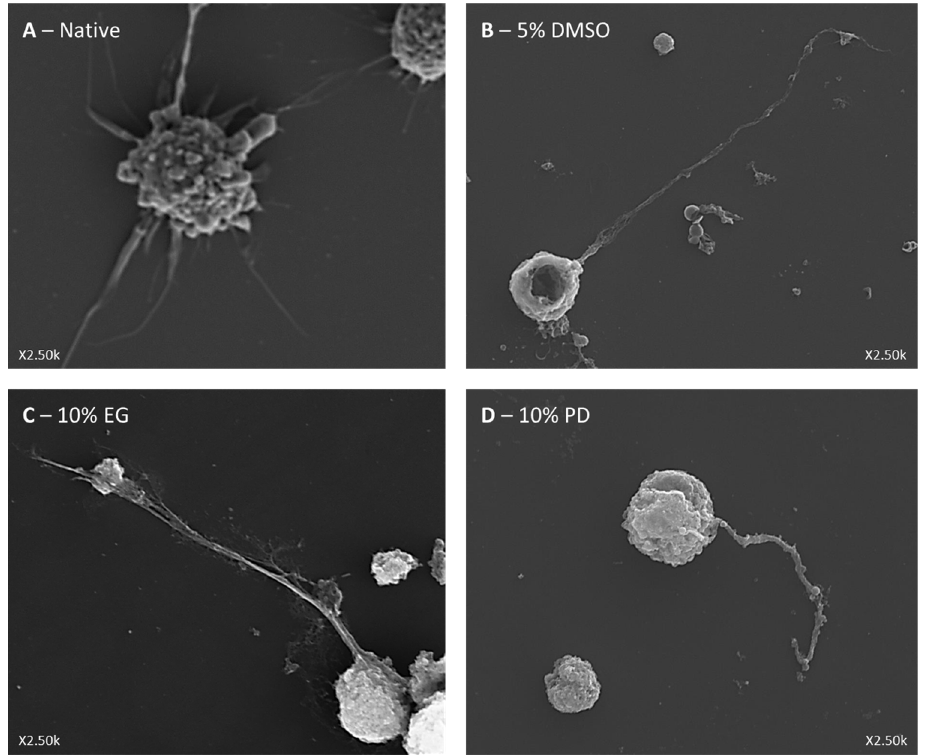
Figure 7. Ultrastructural analysis of proPLT formation by in vitro iPSC-derived MKs before ( A ) and after (( B )—5% DMSO; ( C )—10% EG; ( D )—10% PD) cryopreservation. Magnification ×2.5k.